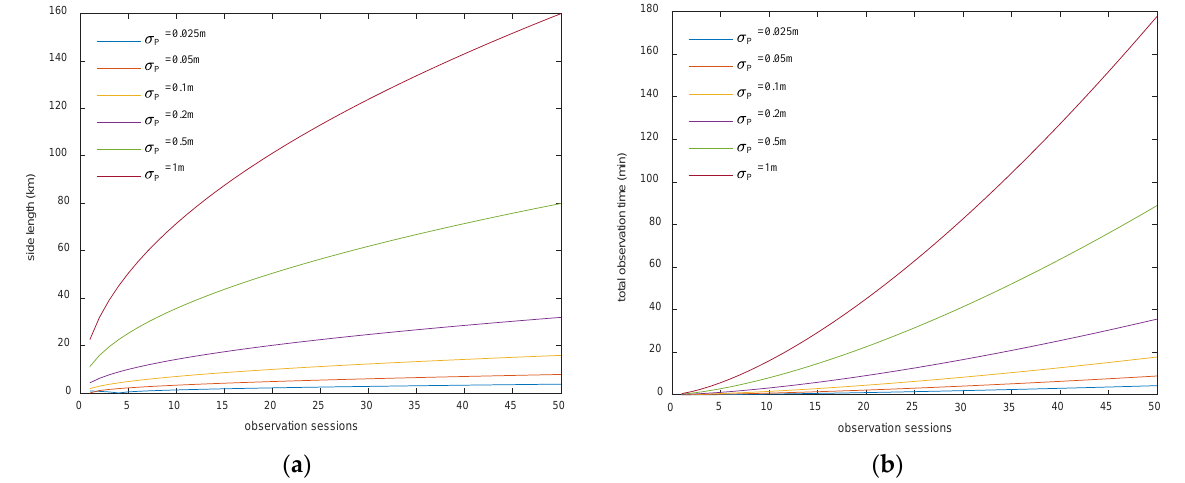
Figure 12. ( a ) The relations between the side length of the square unit network and the number of observation sessions at all precision levels; ( b ) The relations between the total observation time in the square unit network and observation sessions.